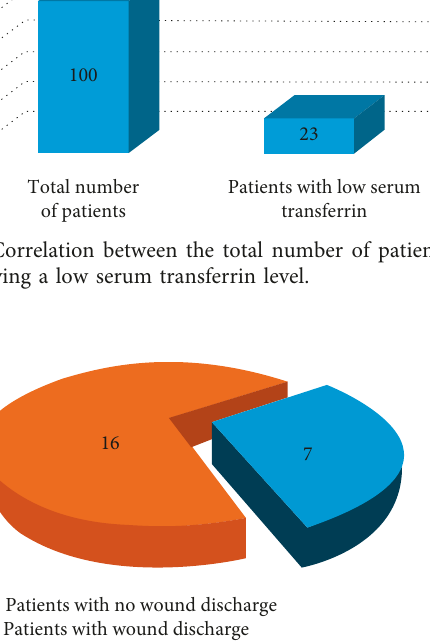
Figure 2: Association between the serum transferrin level and wound drainage.